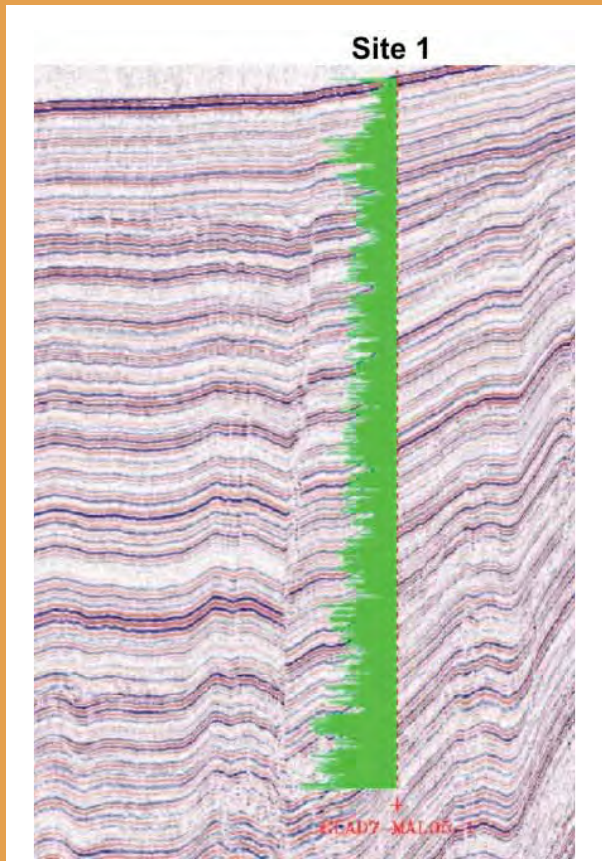
Figure 5. Seismic pro fi le from Site 1 with GRAPE density